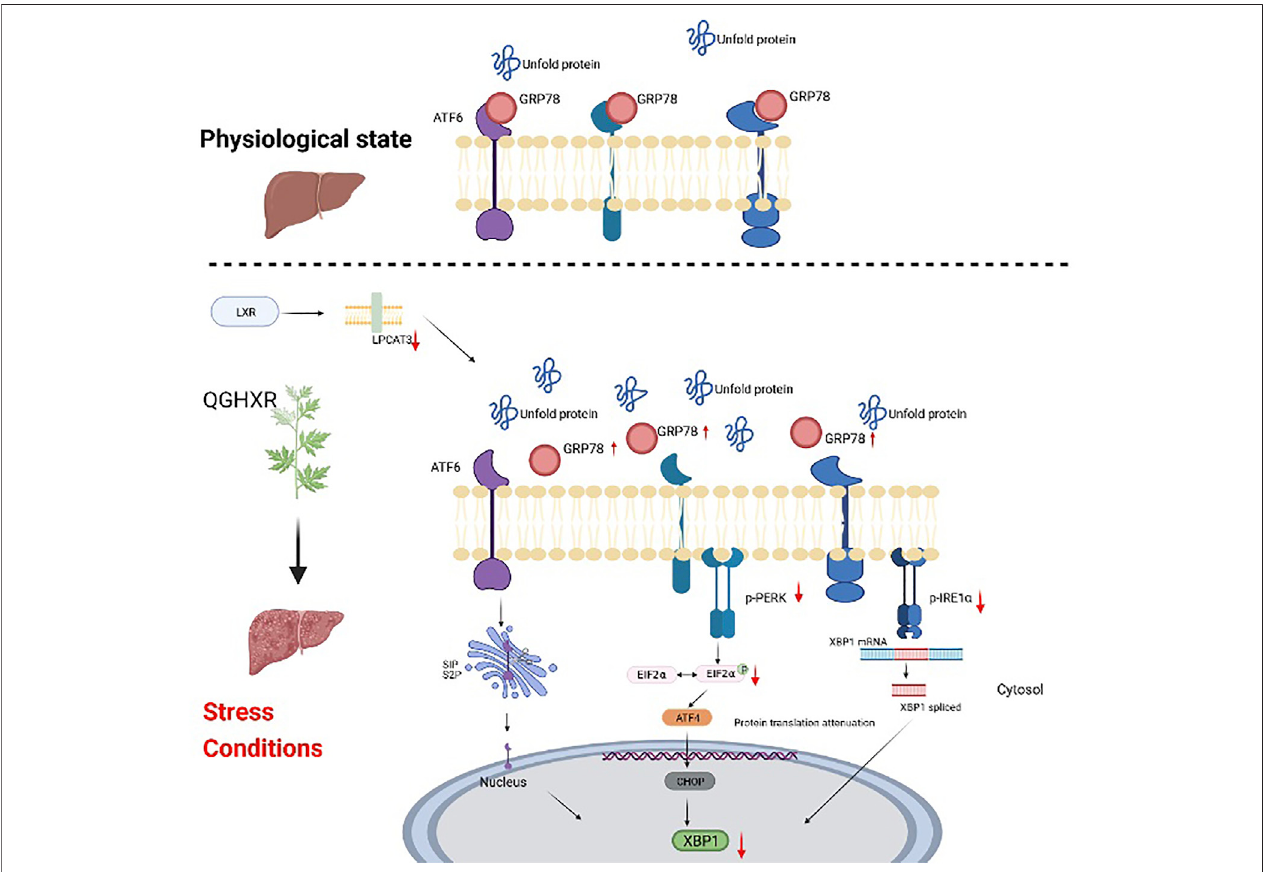
FIGURE5| SchematicdiagramofthemechanismofQGHXRregulatingtheLXR α -LPCAT3signalingpathway.Itwascreatedinthewebsitewww.BioRender.com. QGHXR: Qinggan Huoxue Recipe group; LPCAT3: lysophosphatidylcholine acyltransferase 3; LXR α : liver X receptor alpha; PERK: protein kinase R-like ER kinase; eIF2 α :eukaryotictranslationinitiationfactor2 α ;ATF6:activatingtranscriptionfactor6;IRE1:inositol-requiringenzyme1;XBP1:X-box-bindingprotein1;ATF4:activating transcription factor 4; CHOP: C/EBP homologous